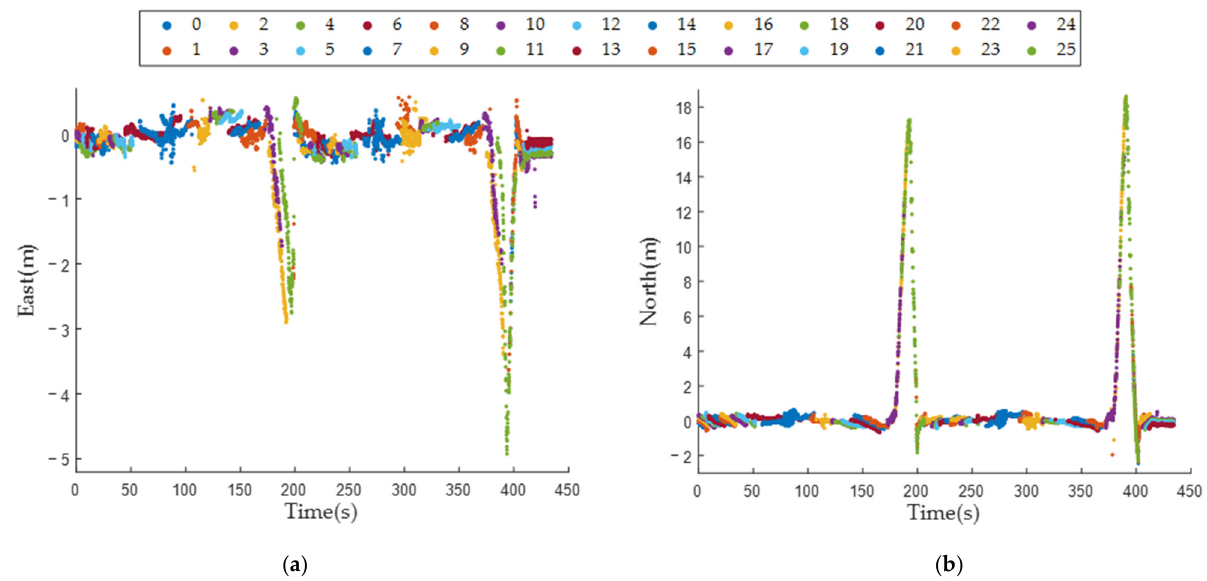
Figure 21. The position deviations of the single frame matched targets in the east and north. ( a ) The position error of the matched targets in the east. ( b ) The position error of the matched targets in the north.